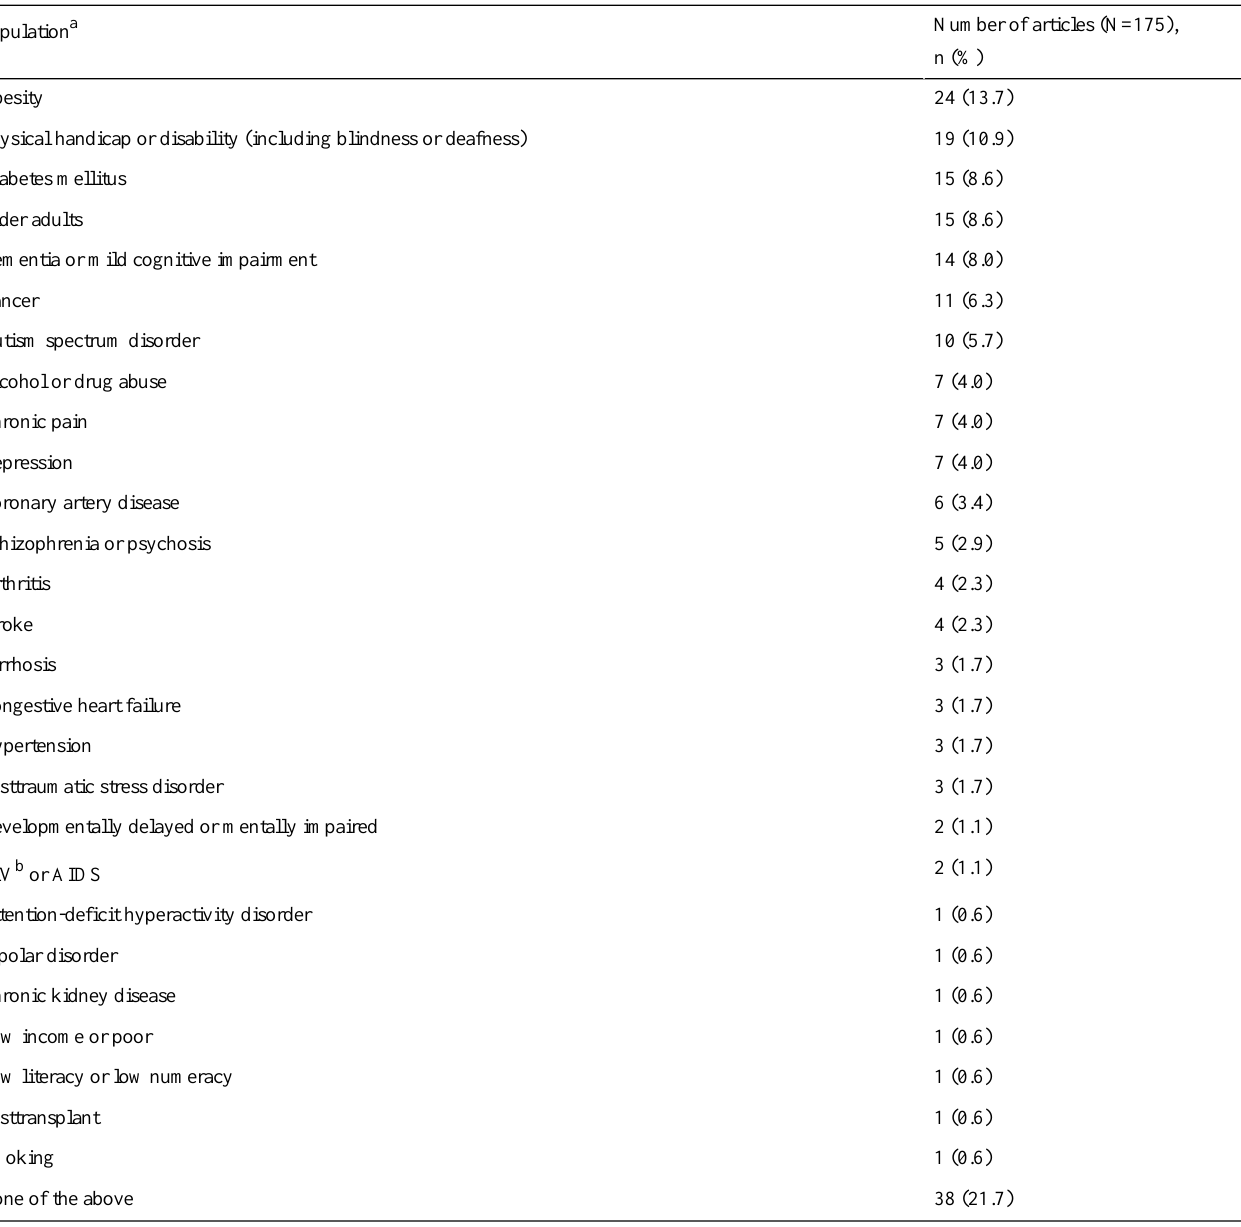
Table 2. Primary population that would benefit from the app